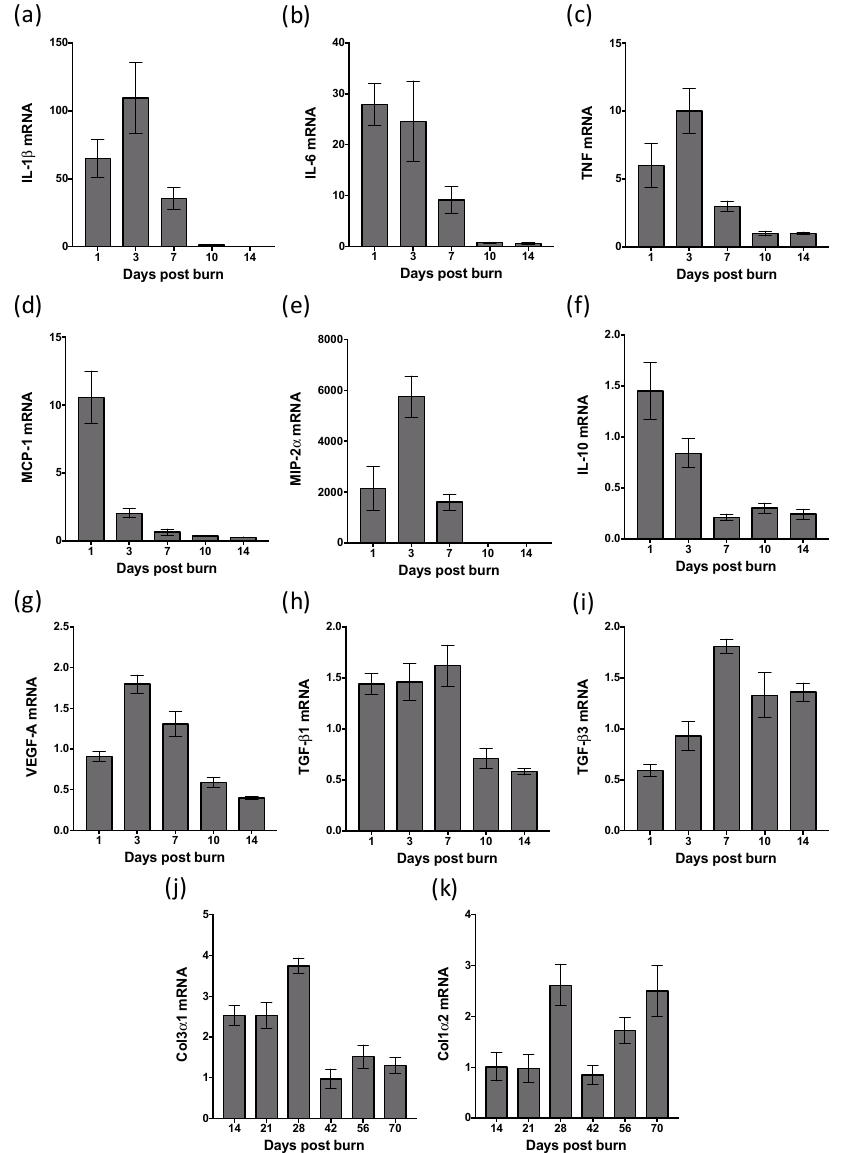
Figure 5. Profile of gene expression during healing and scarring of heated rod burns. Quantitative PCR was used to measure expression of ( a ) IL-1 β , ( b ) IL-6, ( c ) TNF, ( d ) MCP-1, ( e ) MIP-2 α , ( f ) IL-10, ( g ) VEGF-A, ( h ) TGF- β 1, ( i ) TGF- β 3 ( j ) Col3 α 1, and ( k ) Col1 α 2 in samples taken of healing skin. The level of mRNA is relative to that of TATA box binding protein (TBP) and normal skin. Data represents the mean ± SEM, n = 4.